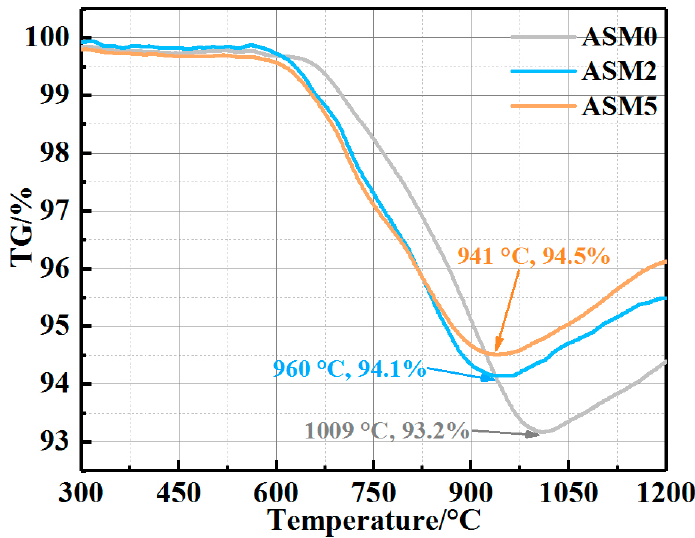
Figure 5. TG curves of the sample matrix in the air.